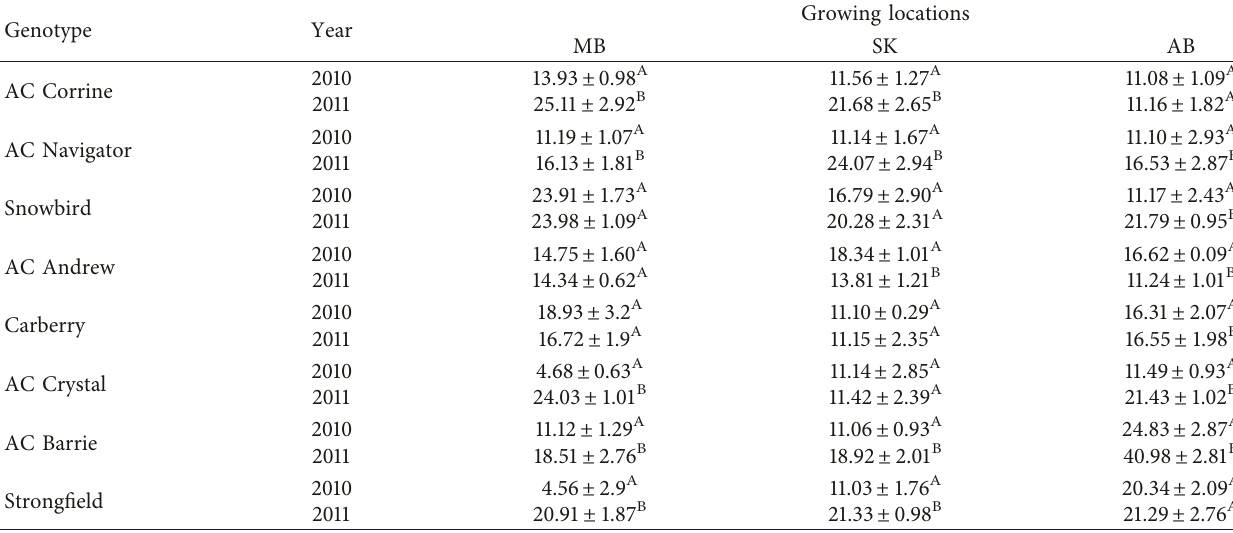
Table 1: Free phenolic acid contents (microgram per gram of dry matter) in the whole grain of 8 wheat varieties grown in three locations in 2010 and 2011 crop years.